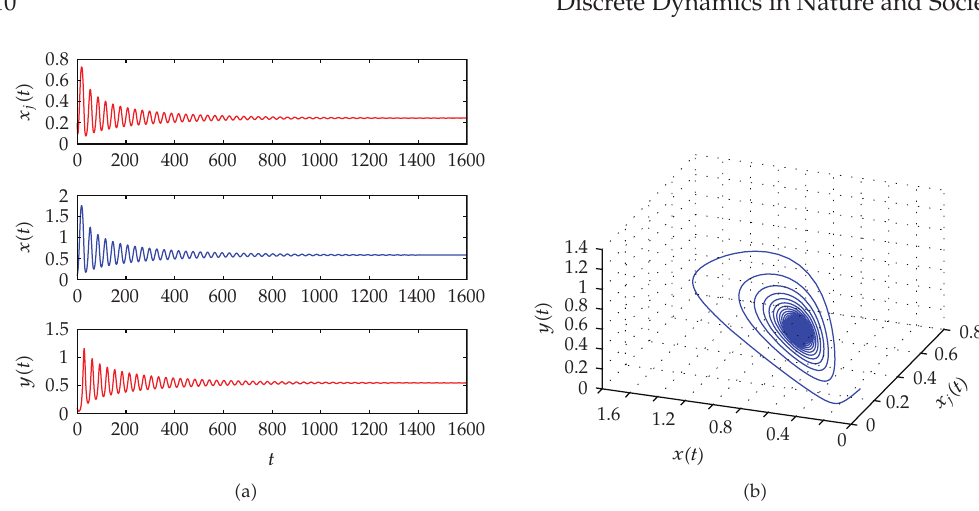
Figure 1: Dynamical behavior of system (cid:6) 4.2 (cid:7) with a (cid:8) 0 . 8, b 1 (cid:8) 0 . 9, τ (cid:8) 0 . 7, f (cid:8) 0 . 2, β (cid:8) 0 . 9, η (cid:8) 1, b 2 (cid:8) 0 . 3, λ (cid:8) 0 . 9, initial values x j (cid:6) 0 (cid:7) (cid:8) 0 . 2, x (cid:6) 0 (cid:7) (cid:8) 0 . 1, y (cid:6) 0 (cid:7) (cid:8) 0 . 1. (cid:6) a (cid:7) Time series of system (cid:6) 4.2 (cid:7) . (cid:6) b (cid:7) Phase portrait of system (cid:6) 4.2 (cid:7)